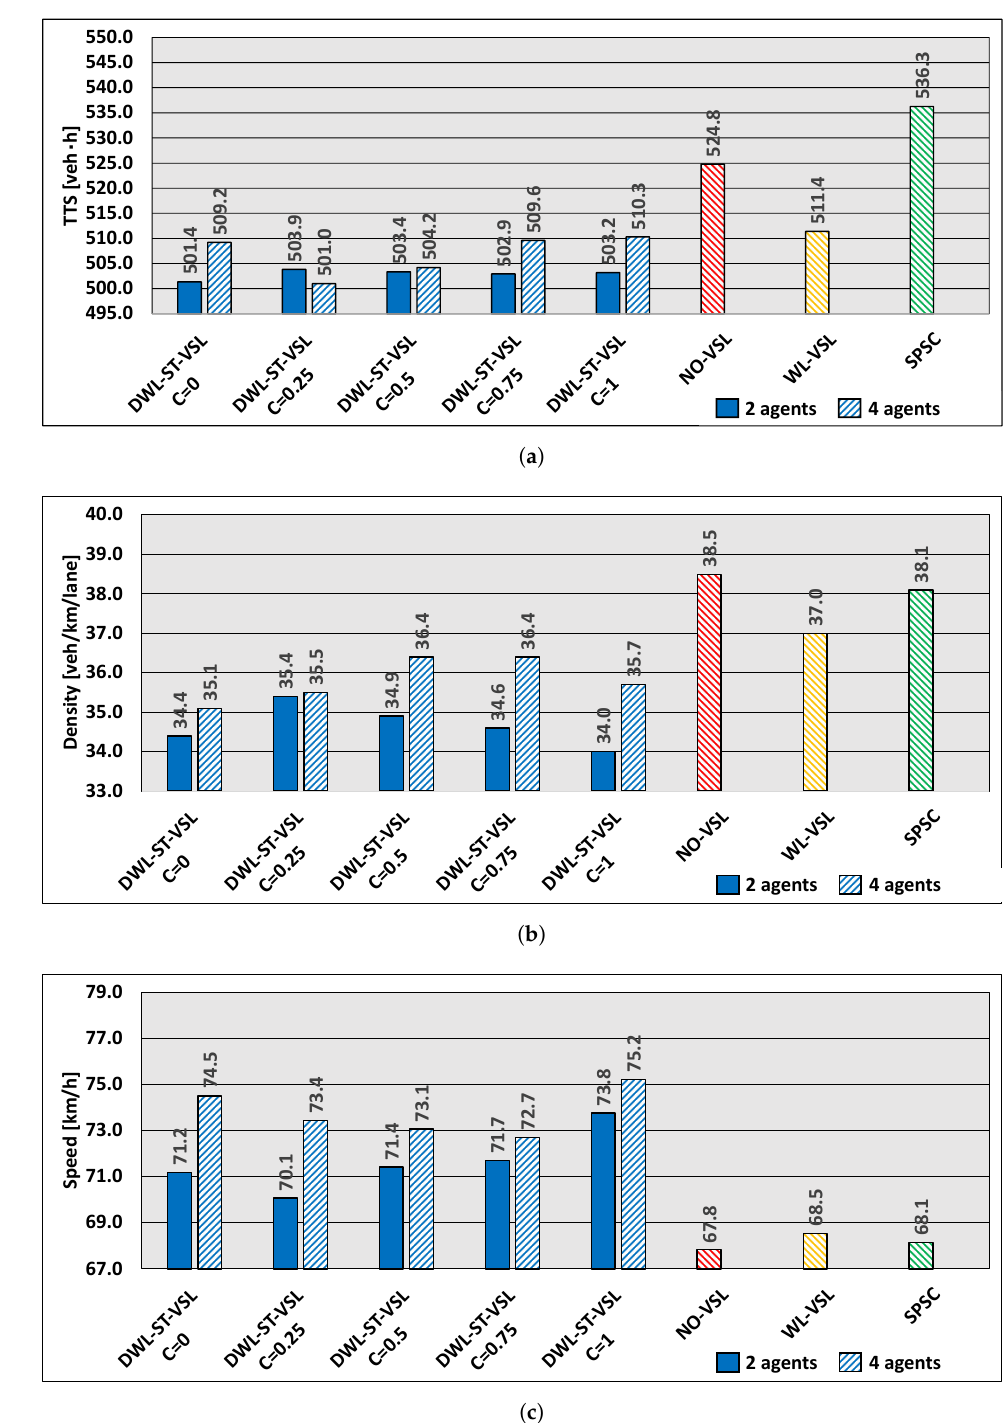
Figure 7. Traffic parameters for different levels of cooperation for the high traffic load scenario. ( a ) TTS in the overall network. ( b ) Average traffic density in section S 0 . ( c ) Average vehicle speed in section S 0